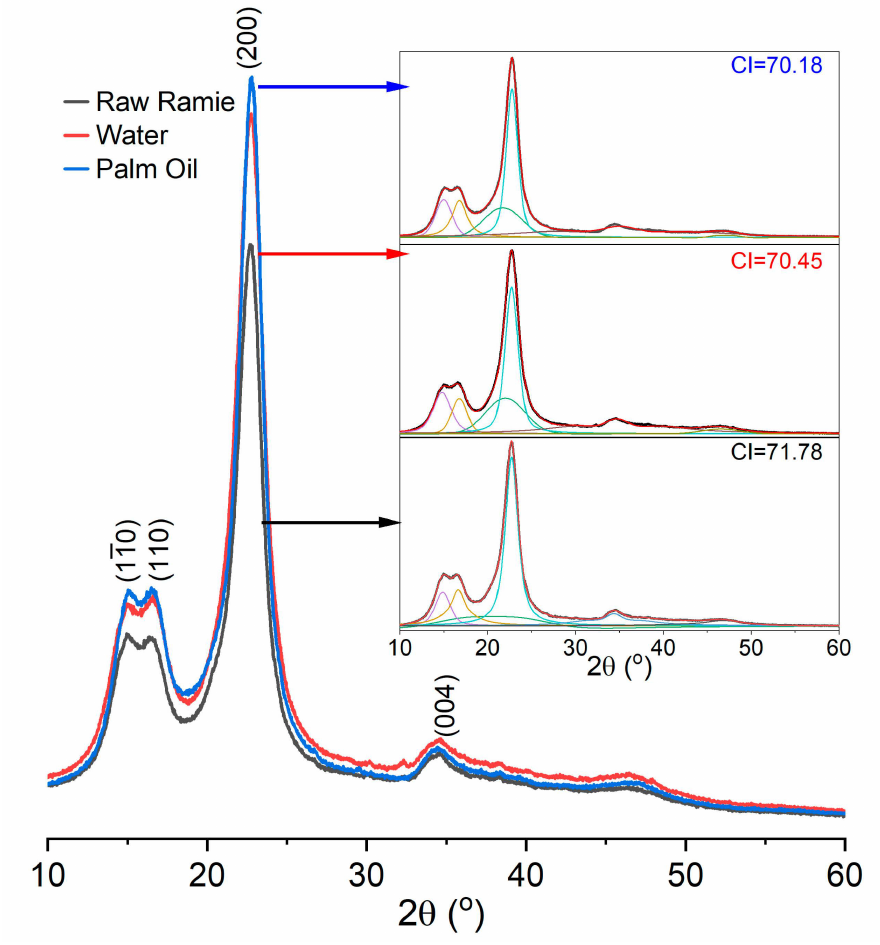
Figure 6. XRD patterns of original raw ramie yarn and raw ramie yarn dyed in the palm oil medium and the water medium, and original raw ramie